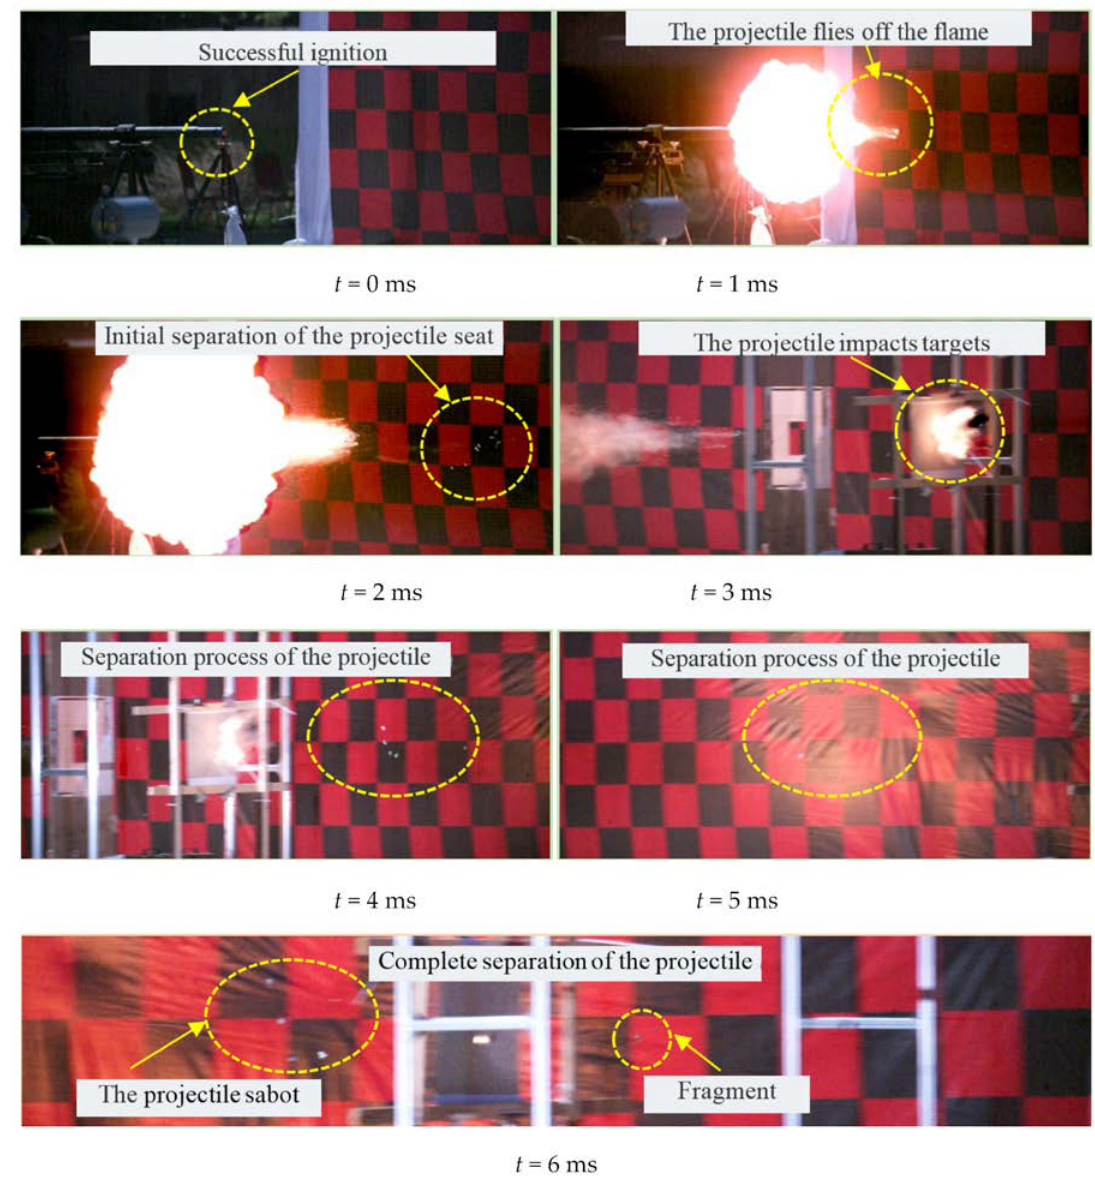
Figure 6. Flight processes of fragment and projectile